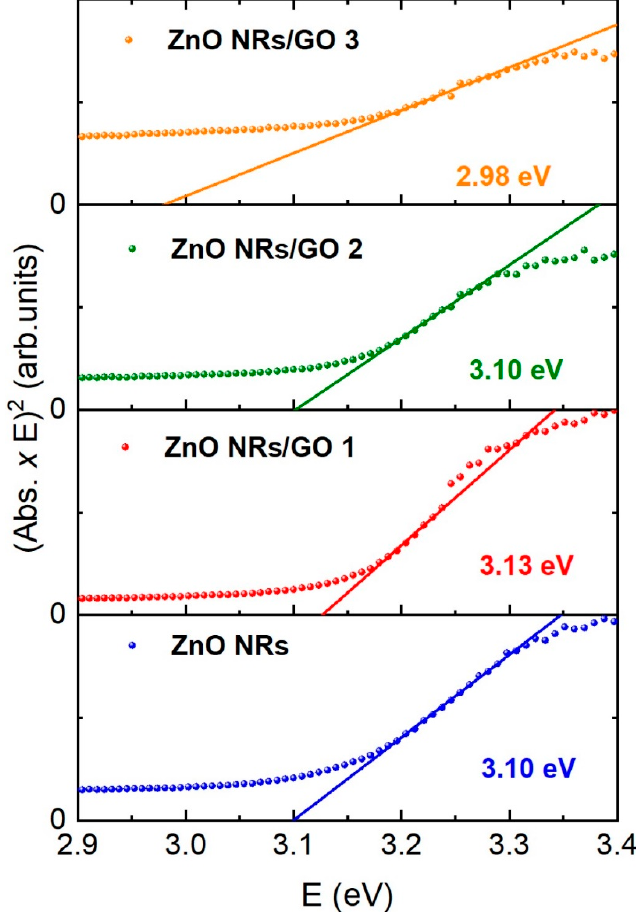
Figure 9. Tauc plots to determine the energy band gaps on the GO amount in ZnO NRs and ZnO NRs / GO NRs/GO nanocomposites.